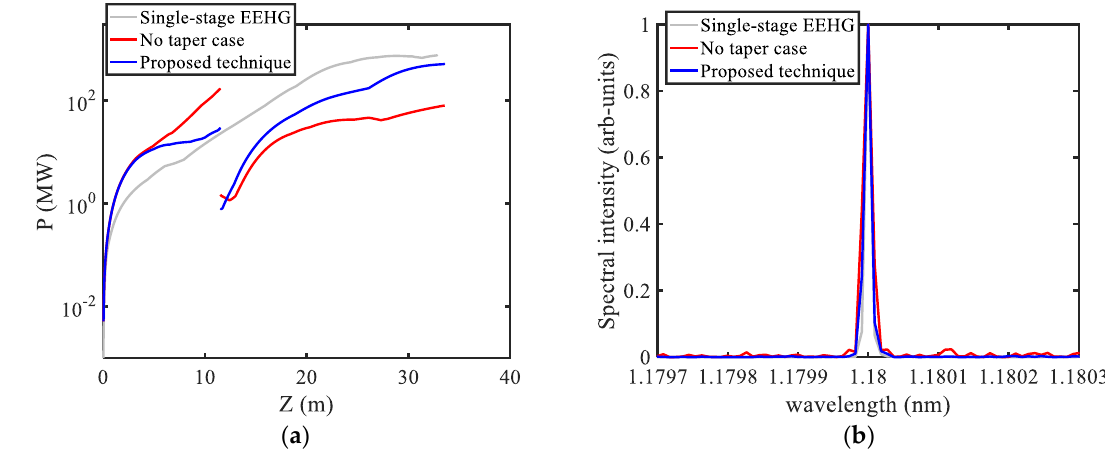
Figure 6. ( a ) The FEL peak power 𝑃 evolutions along the undulator (reverse tapered undulator and radiator) for single-stage EEHG (gray), the proposed technique without taper (red) and with reverse taper (blue); ( b ) The saturation spectra for these three cases.